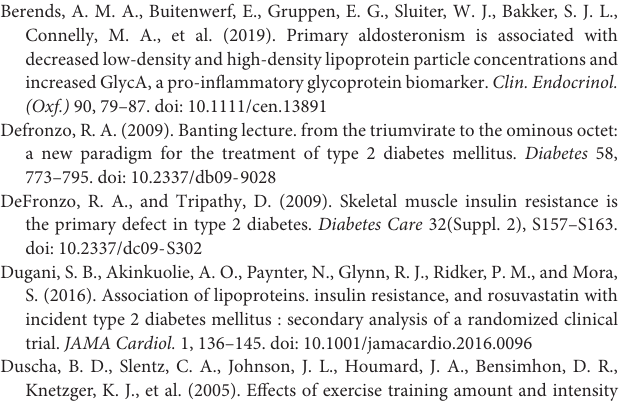
Supplementary Figure 1 | Distribution of individual responses for change in Lipoprotein Insulin Resistance Index (LP-IR) following 8 months of exercise training in STRRIDE AT/RT. Each bar represents an individual participant’s change score. (A) Aerobic training only, (B) resistance training only, and (C) aerobic plus resistance training. Supplementary Figure 2 | Distribution of individual responses for change in Diabetes Risk Index following 6 months of exercise training in STRRIDE-PD. Each bar represents an individual participant’s change score. (A) Low amount/moderate intensity aerobic training, (B) high amount/moderate intensity aerobic training, (C) high amount/vigorous intensity aerobic training, and (D) low amount/moderate intensity aerobic training plus